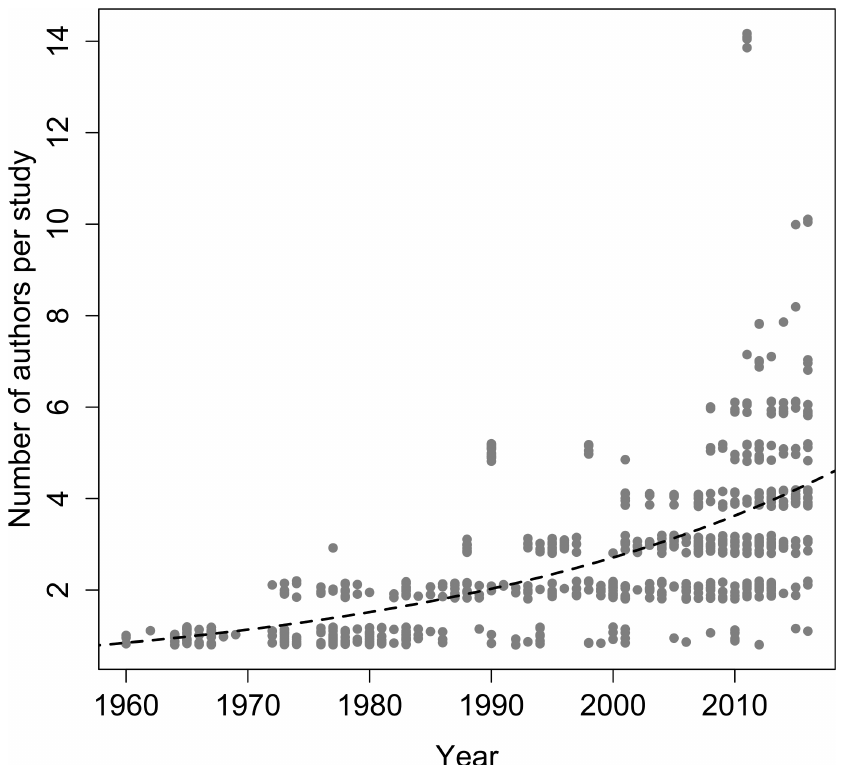
Fig 7. Evolution in the number of authors of studies with descriptions of advertisement calls of Brazilian anurans between 1960 and 2016. Regression function and line fitting the number of authors of each study and the year of